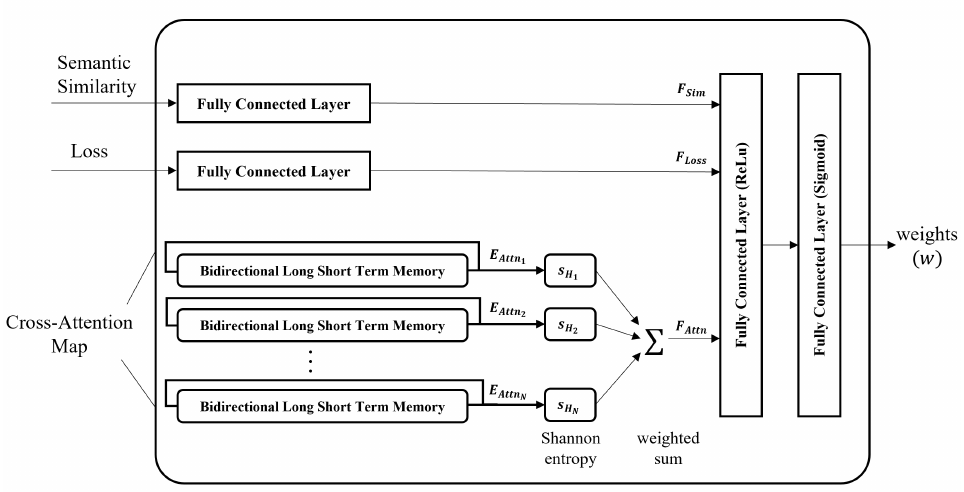
Figure 2. The architecture of